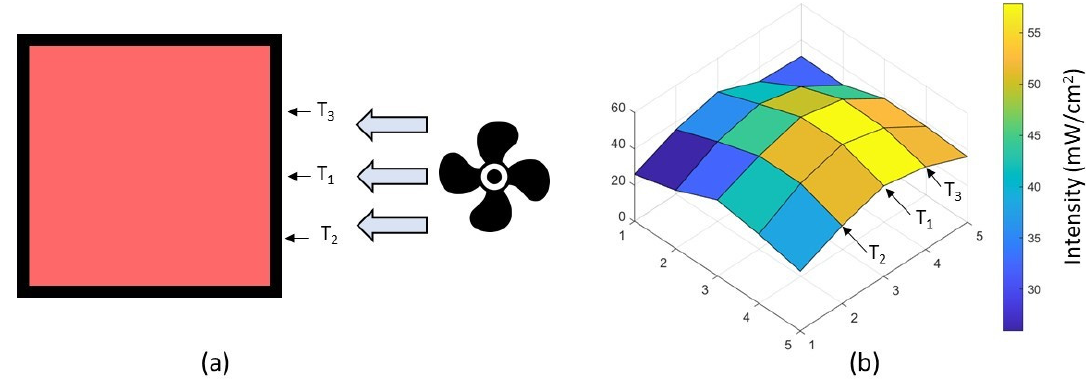
Figure 3. ( a ) Position of thermocouple and fan during the experiments; ( b ) light intensity distribution and thermocouple position during the experiments. The horizontal axes at the bottom of the plot show the grid over which the light intensity was measured.